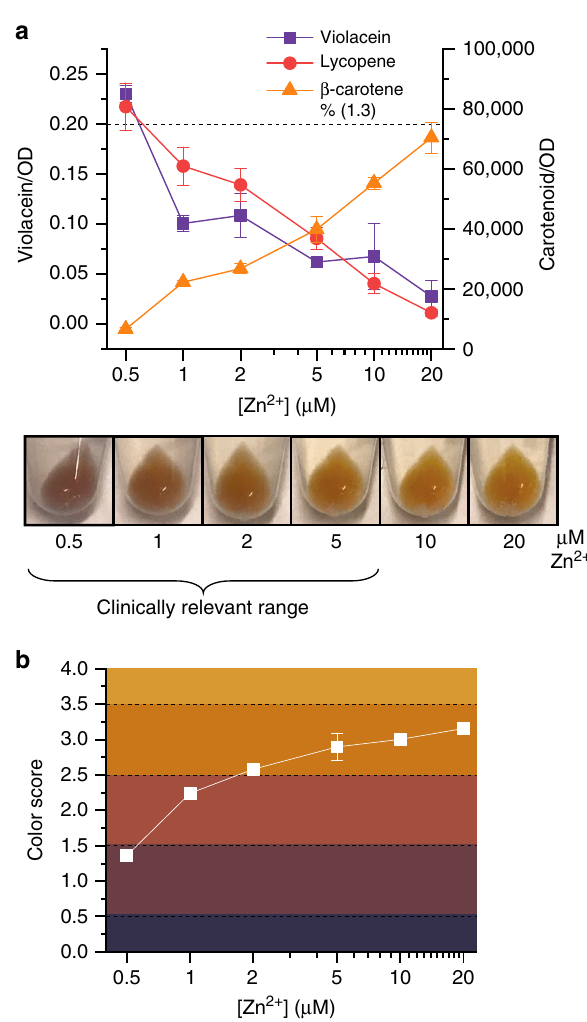
Fig. 5 Assessment of zinc concentration in human serum. a Pigment quanti fi cation and visualization of sensor cells grow in 25% serum with IPTG and speci fi ed zinc concentrations. Assessment was performed four hours after inoculation. Cells are visibly purple, red, or orange across a range of physiologically relevant zinc concentrations. The dotted line indicates the threshold for visible violacein. b Quantitative color assessment of sensor cells. Using RGB values taken from images of cell pellets, a color score was calculated for cells grown in each zinc concentration. As indicated by shading on the plot, scores between 0 and 1.5 indicate purple cells, scores between 1.5 and 2.5 indicate red cells, and scores between 2.5 and 4 indicate orange cells. By RGB score quanti fi cation, cells are classi fi ed as either purple, red, or orange across a range of 0.5 to 5 μ M zinc. Data points show the average of three biological replicates, and error bars indicate standard deviation. Source data for a and b are provided in the Source Data fi circuit to show that cells are metabolically active in unprocessed serum as long as they are inoculated to a suf fi ciently high OD (Supplementary Fig. 11), which is consistent with previous work demonstrating that large inocula are required to enable bacterial growth in human serum 11 . We inoculated a very high con- centration (OD initial = 3.0) of the sensor cells containing the plasmid p 3cI,2 into media containing 25% of untreated human serum that had different zinc concentrations. Cells produced different pigments based on the concentration of zinc in the sample, turning either purple, red, or orange across a physiolo- gically relevant range of zinc concentrations (Fig. 5a).